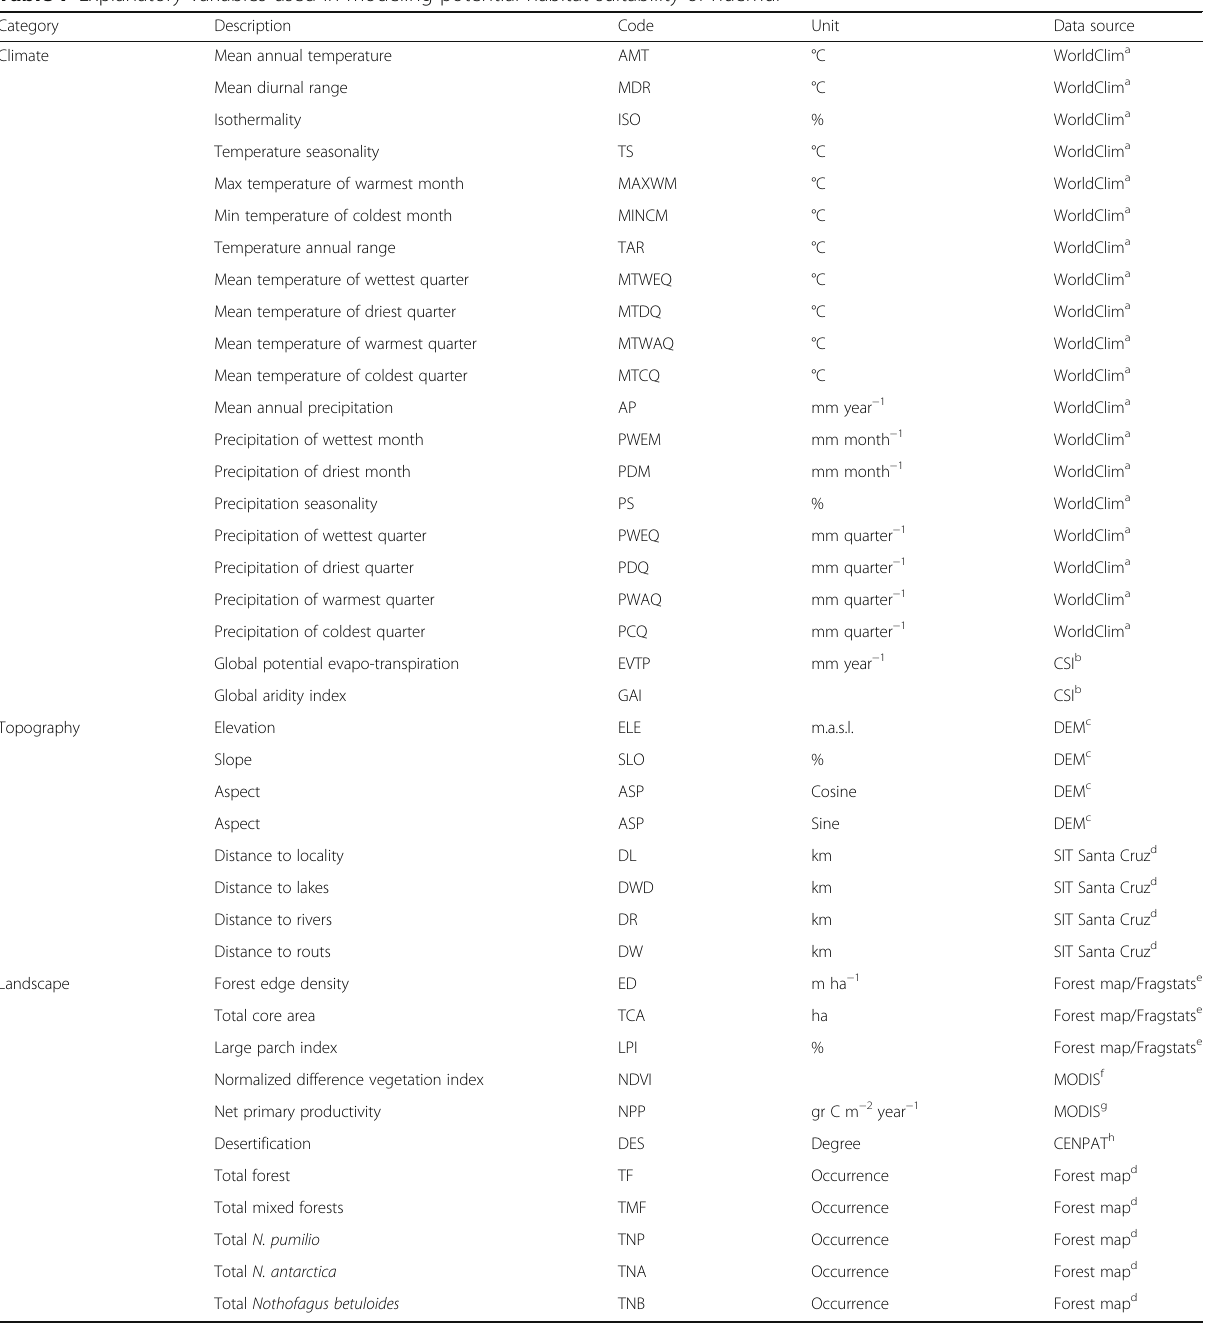
Table 7 Explanatory variables used in modeling potential habitat suitability of